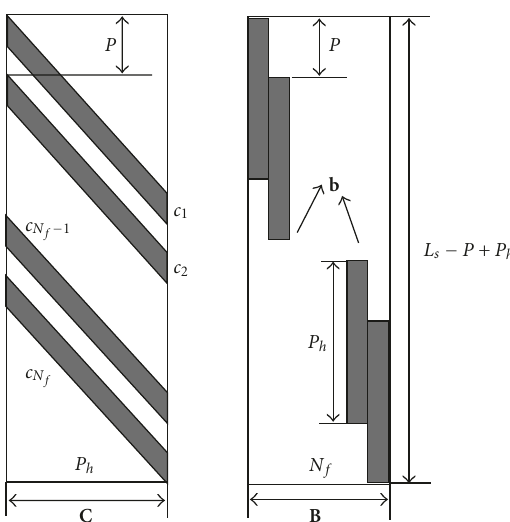
samples with di ff erent variances. The matrix Λ , which collects the variances of each element in N 1 ,